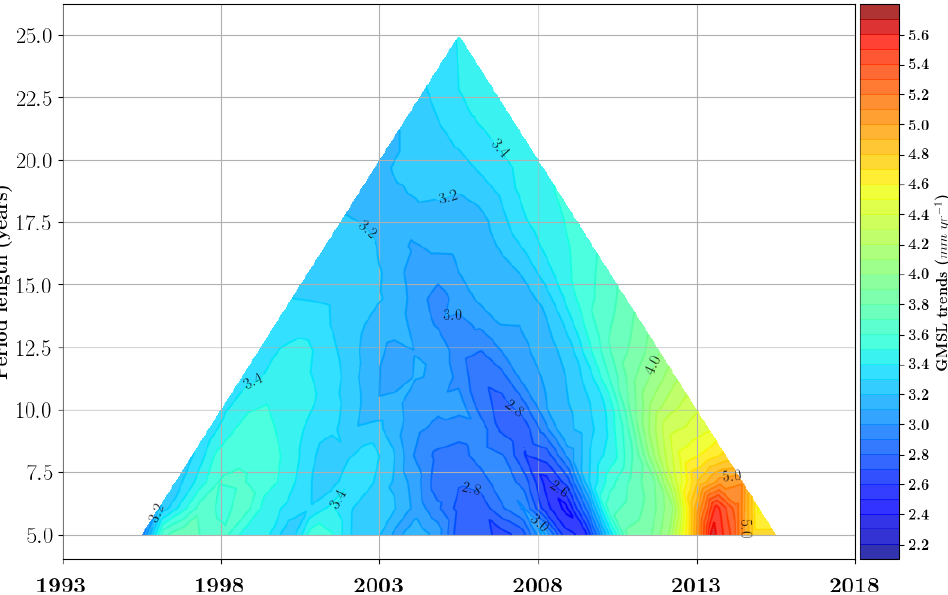
Figure 9. GMSL trends using the AVISO GMSL time series corrected for the TOPEX-A drift using the correction proposed by Ablain (2017). The length of the window (in years) is represented on the vertical axis and the central date of the window used (in years) is represented on the horizontal axis. A GIA correction of − 0 . 3mmyr − 1 has been subtracted. A correction of + 0 . 10mmyr − 1 due to the deformations of the ocean bottom in response to modern melt of land ice (Frederikse et al., 2017; Lickley et al., 2018) has also been